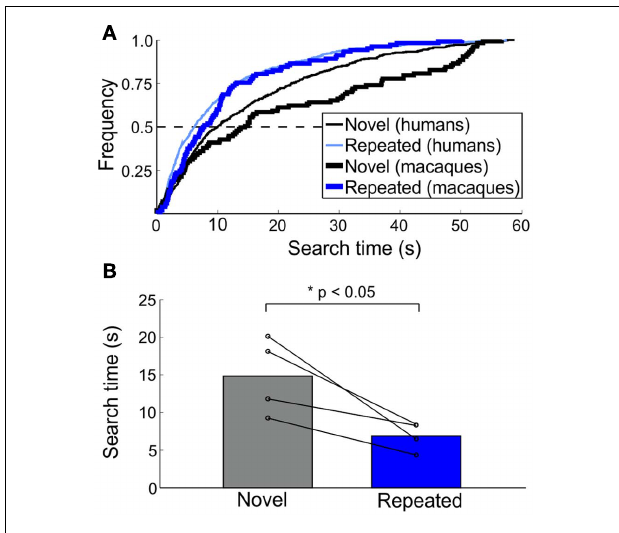
FIGURE 4 | Macaque search time patterns in Experiment 2. (A) Cumulative frequency of search times for novel and repeated trials across species. Human data from Figure 3A is plotted alongside macaque data (bolded lines) for comparison. (B) Median search times for novel and repeated trials. Population data is shown by bars; individual macaque median search times indicated by each line. FIGURE 5 | Behavioral performance of amnesic patient D.A. in